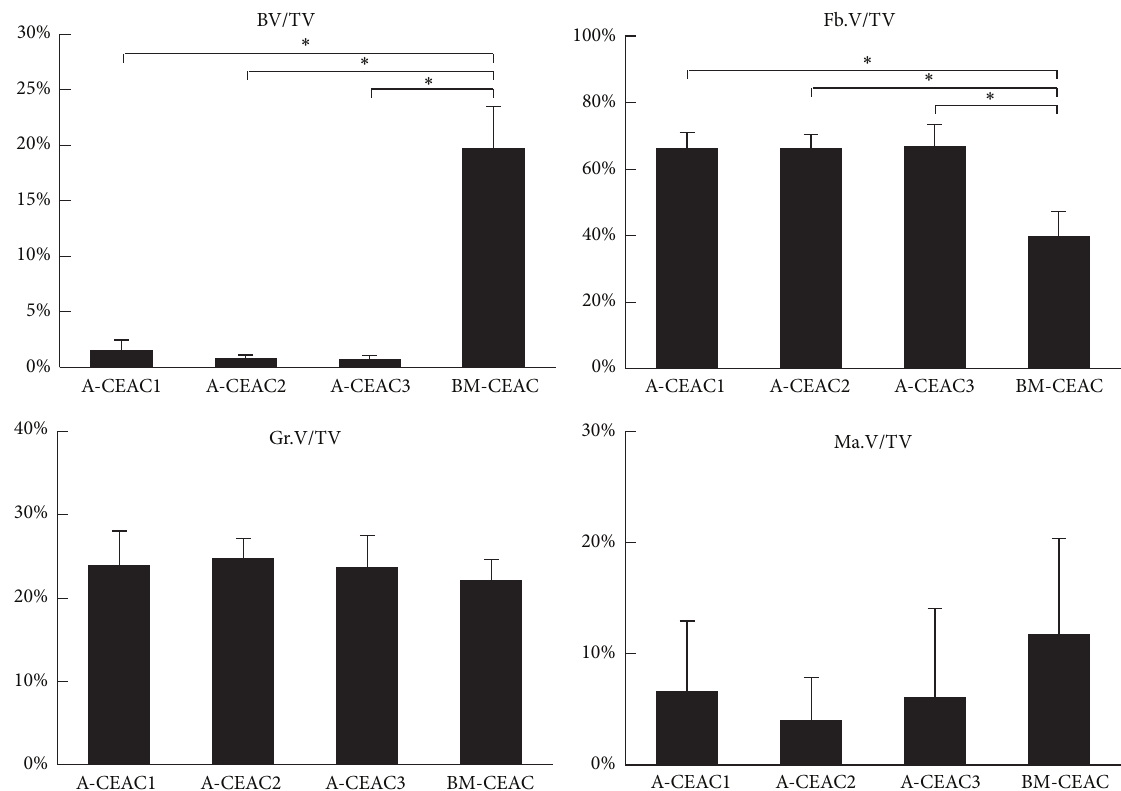
Figure 2: Amount of newly formed bone tissue (BV), fibrous tissue (Fb.V), residual granules (Gr.V), and bone marrow (Ma.V) relative to total tissue volume (TV). A-CEAC1: 0.5 × 10 6 A-CEAC ( 𝑛 = 10 ); A-CEAC2: 1 × 10 6 A-CEAC ( 𝑛 = 10 ); A-CEAC3: 1.5 × 10 6 A-CEAC ( 𝑛 = 10 ); BM-CEAC: 0.5 × 10 6 BM-CEAC ( 𝑛 = 14 ). ∗ 𝑝 < 0.002 corresponding to 𝑝 < 0.01 prior to Bonferroni